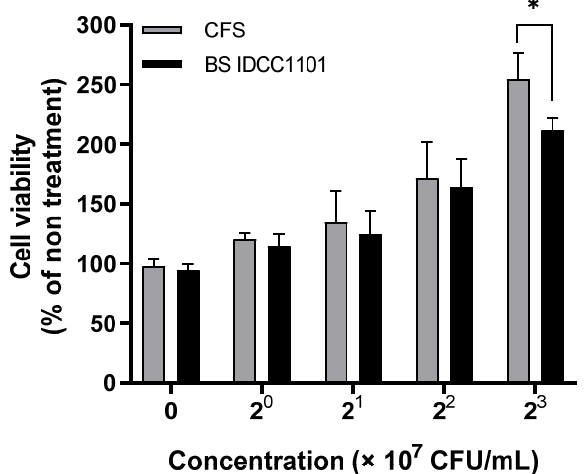
Figure 4. The cytotoxic effect of B . subtilis IDCC1101 on the viability of the HaCaT cell. The data are expressed as mean ± standard deviation across triplicate technical replicates. The symbol (*) indicates significantly different between whole cell and CFS of BS IDCC1101 at p < 0.05.